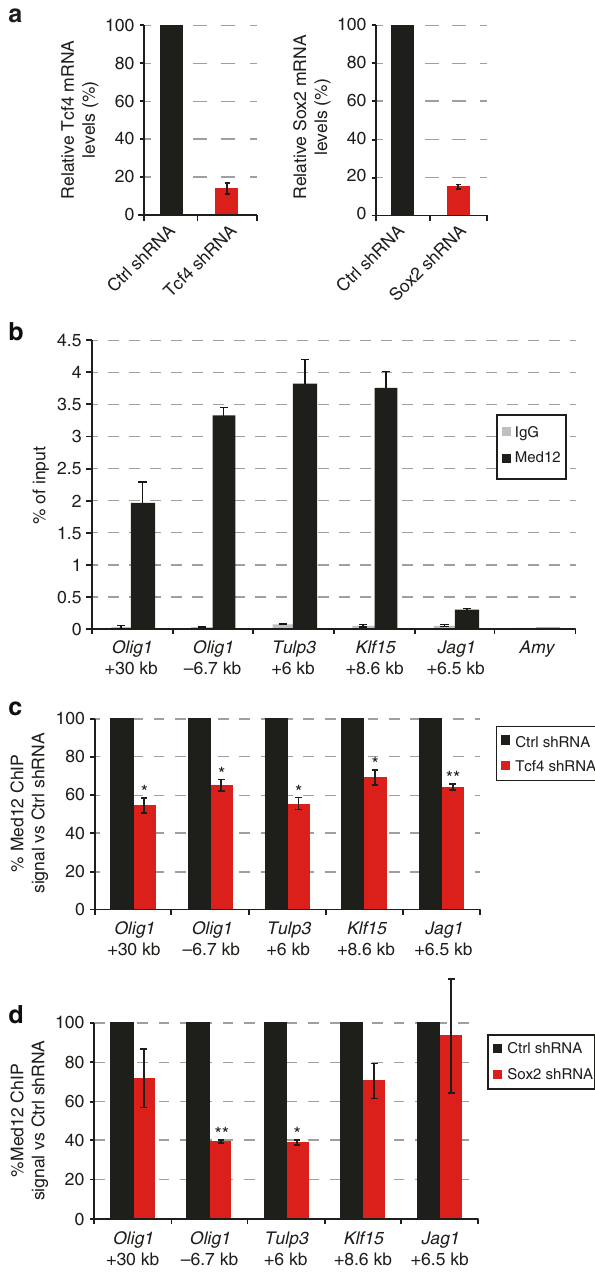
NATURE COMMUNICATIONS |